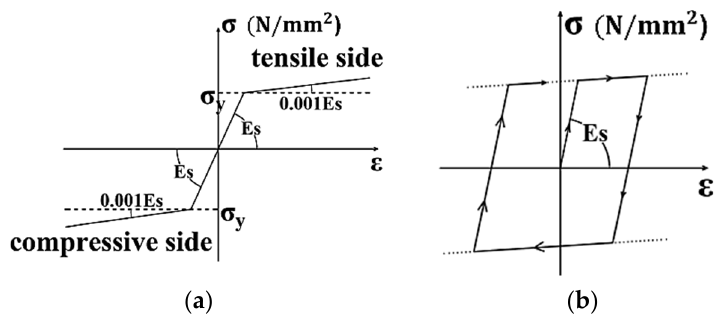
Figure 12. Steel models: ( a ) bi-linear model, and ( b ) kinematic strain-hardening rule. Next, the results of the hysteresis behaviors, the cracking patterns obtained from the FEM analysis were compared with that measured from the experimental study to verify the effectiveness of the FEM modeling. Experimental details, and FEM analysis results, as Section